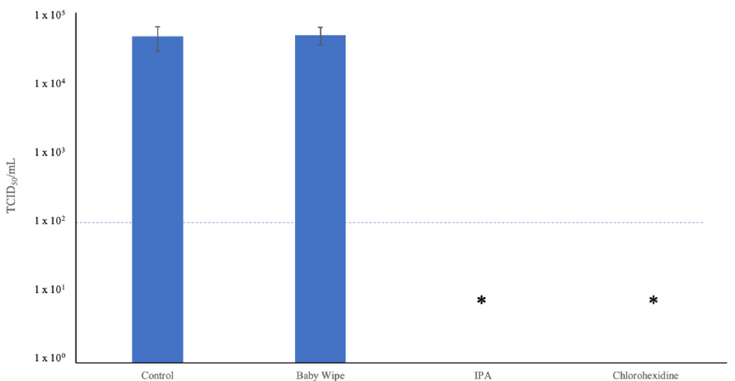
Figure 5. Effect of direct contact of neutralization solutions on dried virus droplets. N = 3; * titer fell below the limit of detection of the assay, meaning absolute reduction in virus yield could not be